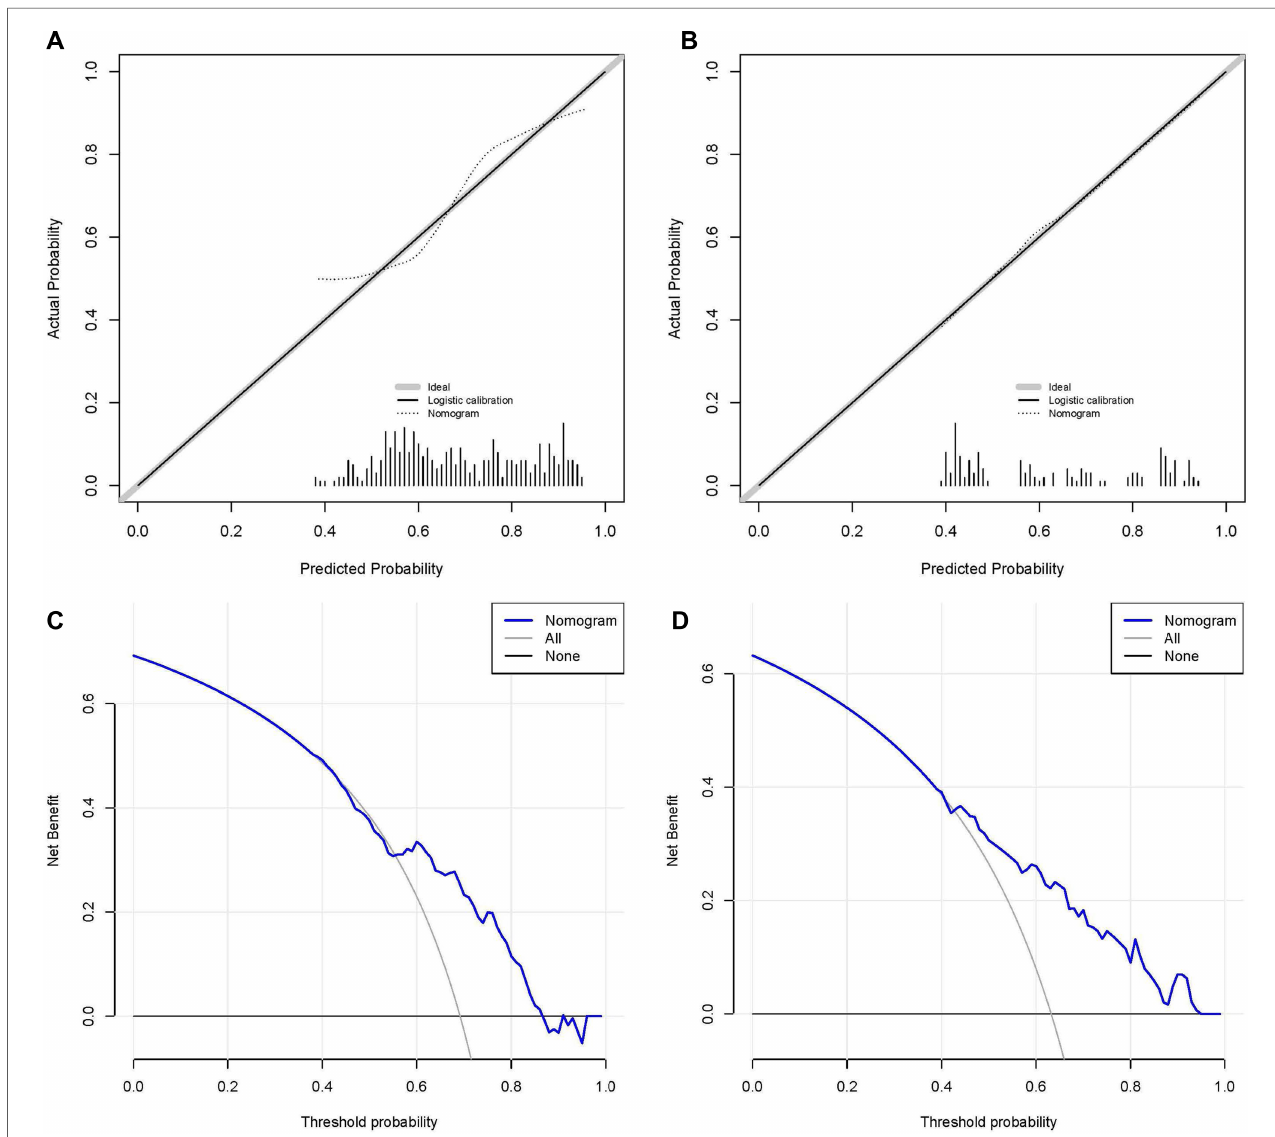
FIGURE 5 Calibration and decision curve analysis. Calibration curves of the nomogram in the training set ( A ) and the validation set ( B ), respectively. The nomogram ’ s decision curve analysis in the training set ( C ) and validation set ( D ),